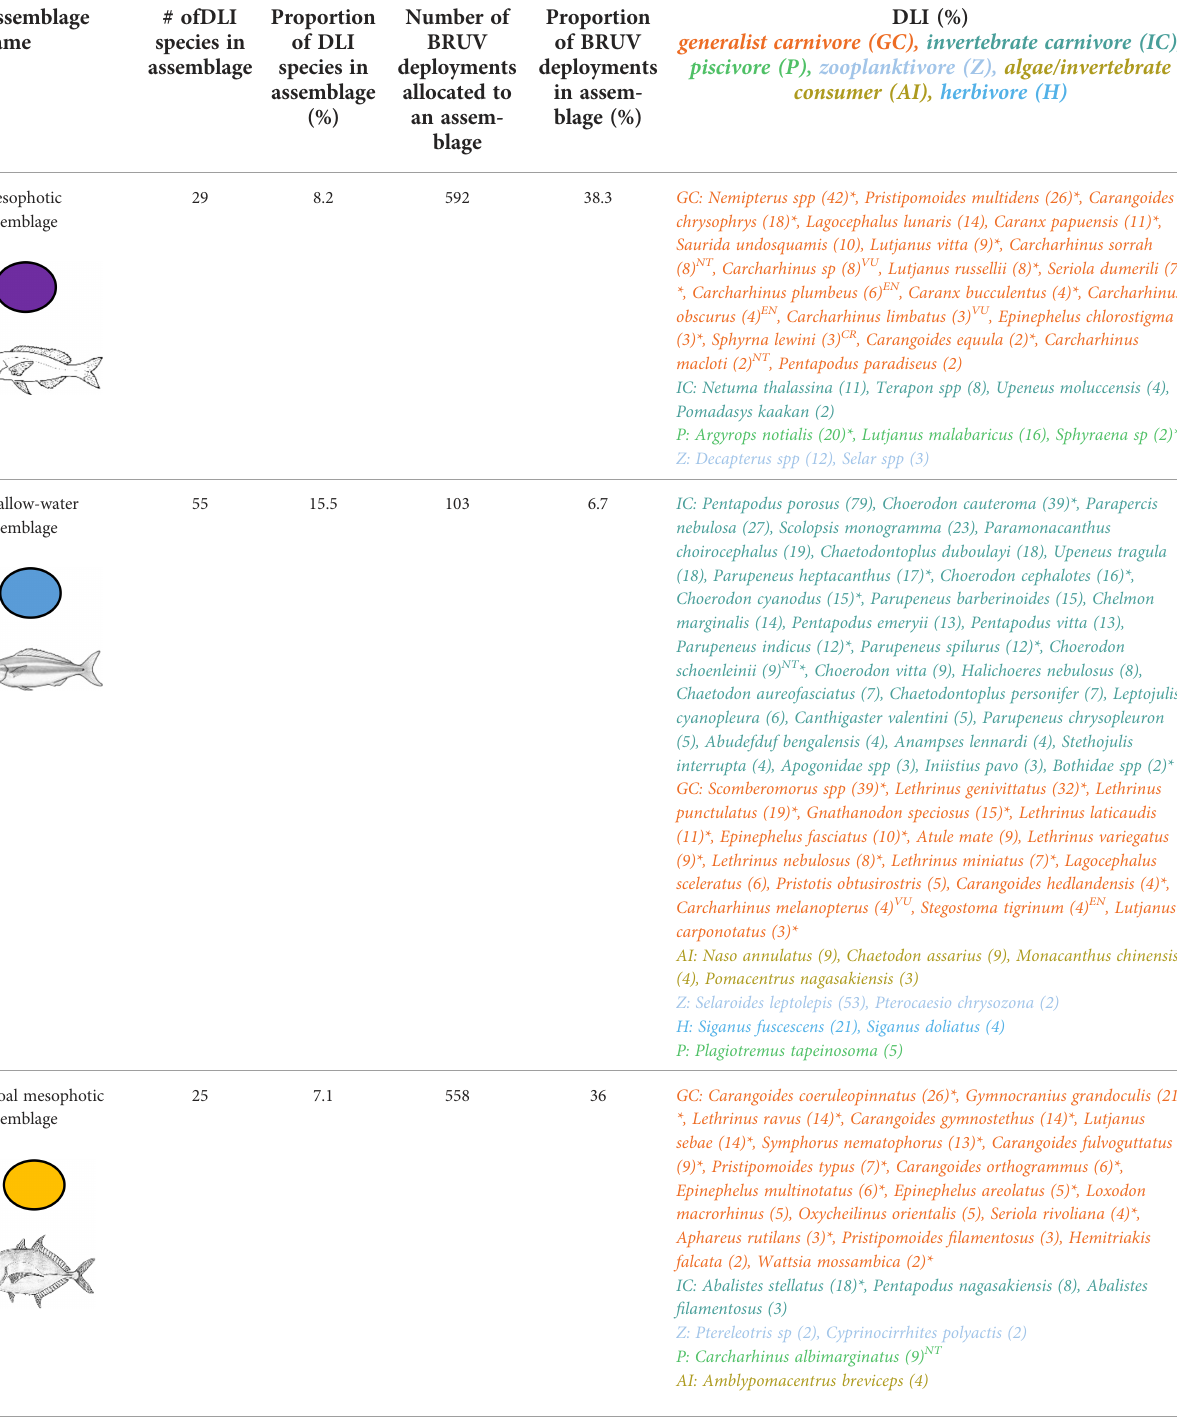
TABLE 2 Summary of indicator taxa in the fi ve fi sh assemblages of the multivariate regression tree (MRT; Figure 4 ). Assemblage